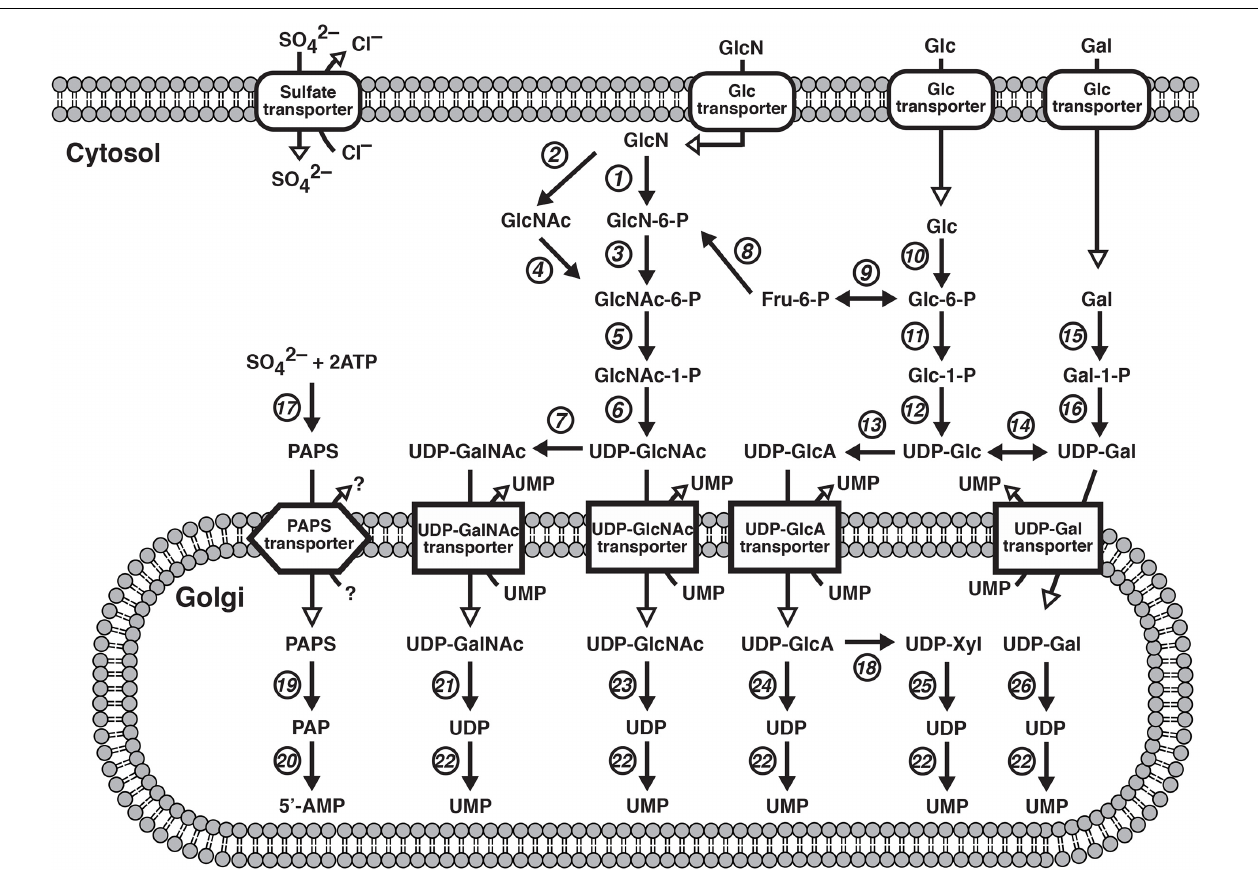
FIGURE 1 | Biosynthetic pathways of UDP-sugars and PAPS. 1, Hexokinase; 2, GlcNH 2 acetyltransferase; 3, GlcNH 2 6-phosphate N -acetyltransferase; 4, GlcNAc kinase; 5, GlcNAc phosphomutase; 6, UDP-GlcNAc pyrophosphorylase: 7, UDP-GalNAc 4-epimerase; 8, glutamine-fructose-6-phosphate aminotransferase; 9, Glc-6-phosphate isomerase; 10, hexokinase; 11, phosphoglucomutase; 12, UDP-Glc pyrophosphorylase; 13, UDP-Glc dehydrogenase; 14, UDP-Glc 4-epimerase; 15, galactokinase; 16, Gal-1-phosphate uridylyltransferase; 17, PAPS synthase; 18, UDP-GlcA decarboxylase; 19, sulfotransferases; 20, adenosine-3 (cid:48) , 5 (cid:48) -bisphosphate 3 (cid:48) -phosphatase; 21, GalNAc transferases; 22, nucleoside 5 (cid:48) -diphosphate phosphatase; 23, GlcNAc transferases; 24, GlcA transferases; 25, Xyl transferases; 26, Gal